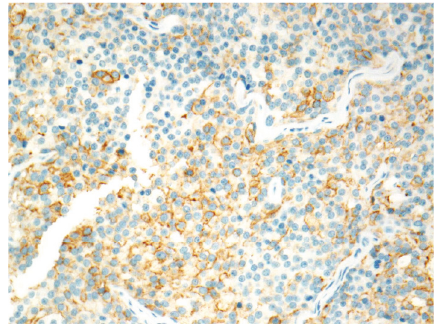
Figure 2: Histology staining of